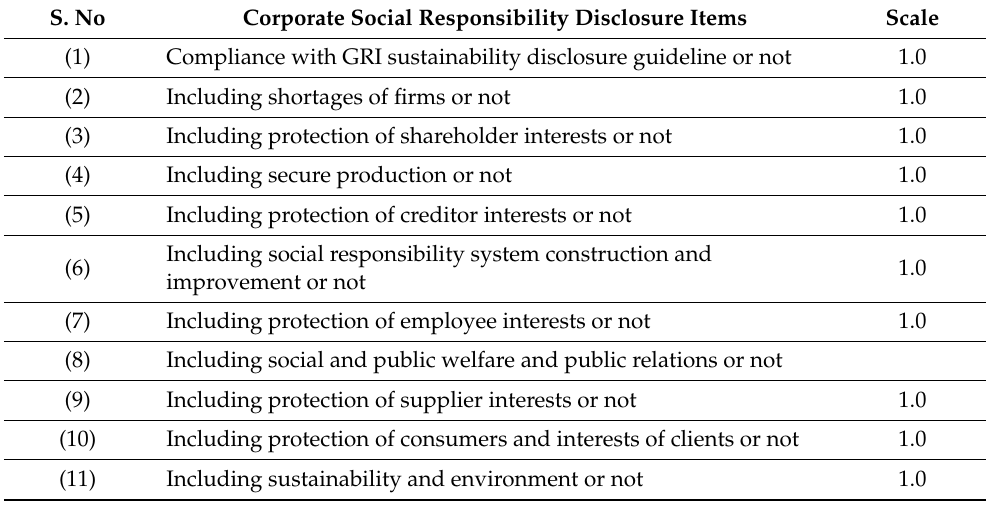
Table 1. Index list of quality of CSR